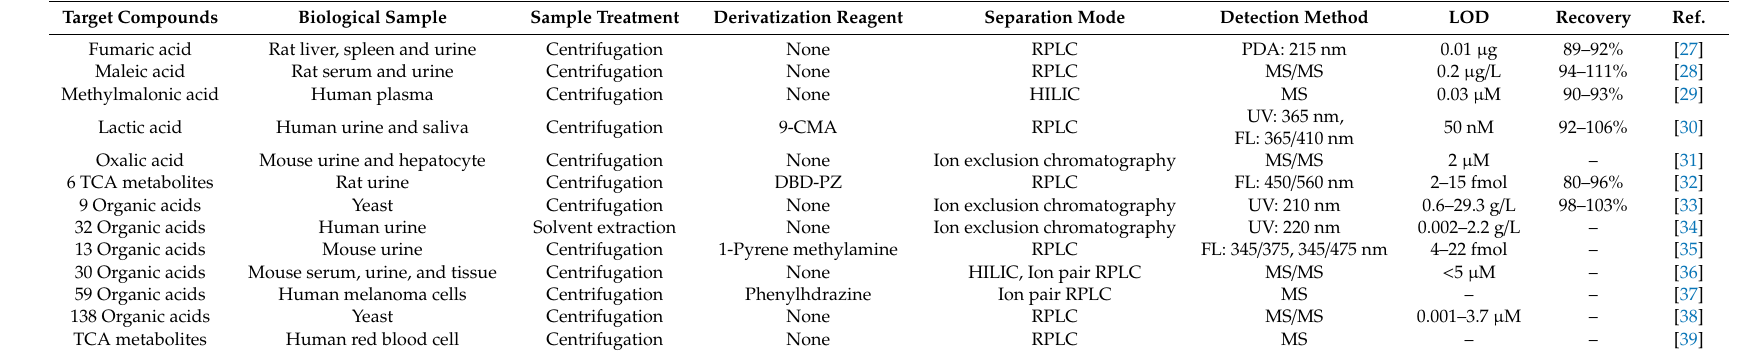
Table 2. Analytical methods for TCA cycle and glycolysis-related compounds in biological samples.